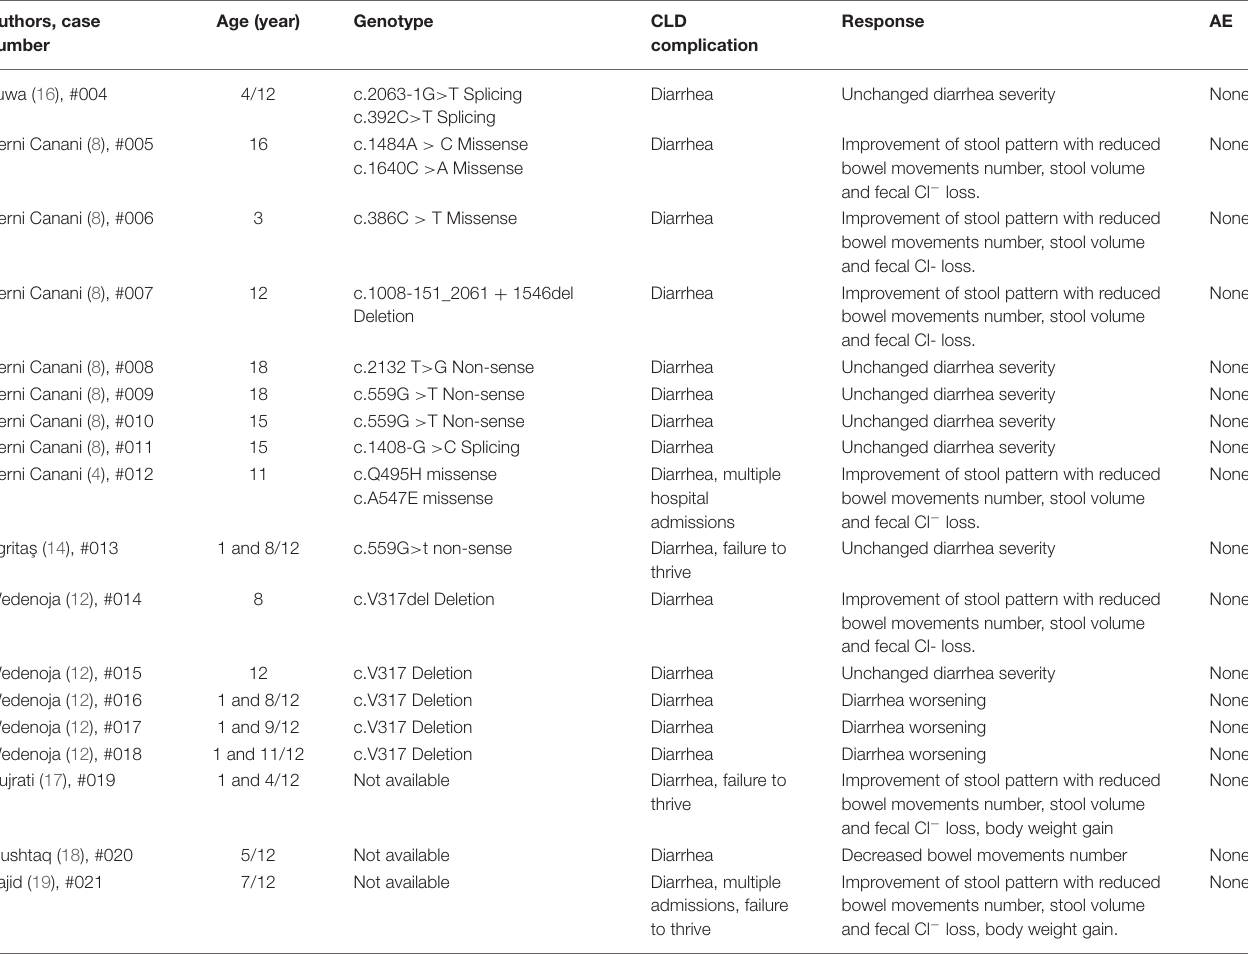
TABLE 2 | Main data reported in literature on butyrate (100 mg/Kg/day) use in